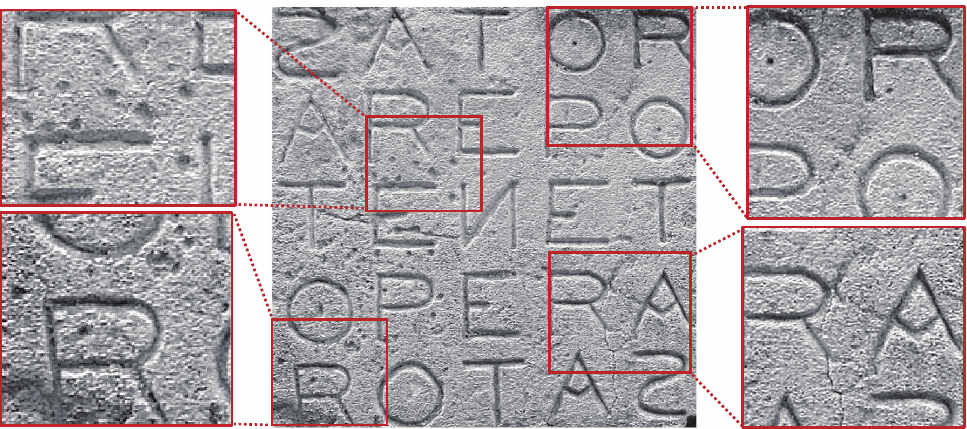
Figure 5. The scanning image for ancient ruins covered with holes and